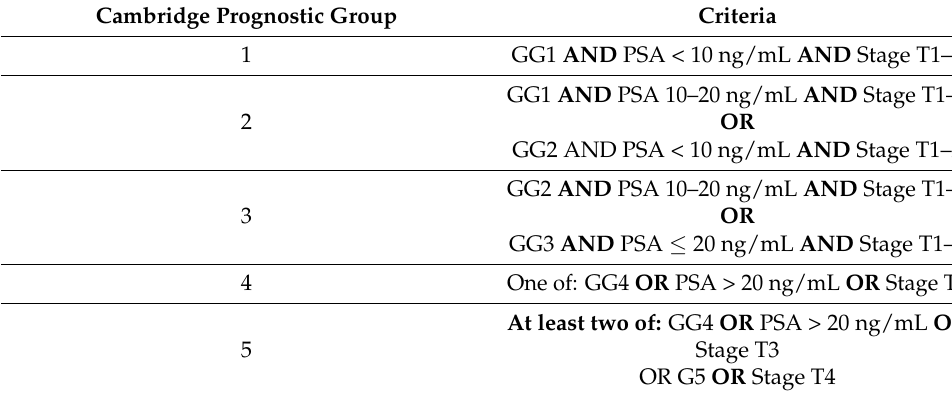
Table 1. Criteria for the Cambridge Prognostic Groups. GG, grade group; PSA, prostate-specific antigen. Cambridge Prognostic